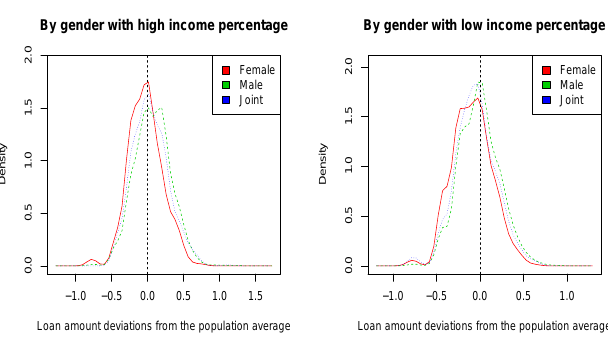
Figure 2. ME loan amount deviations from the population mean based on full data and sub-populations with low/high minority and low/high income percentages.